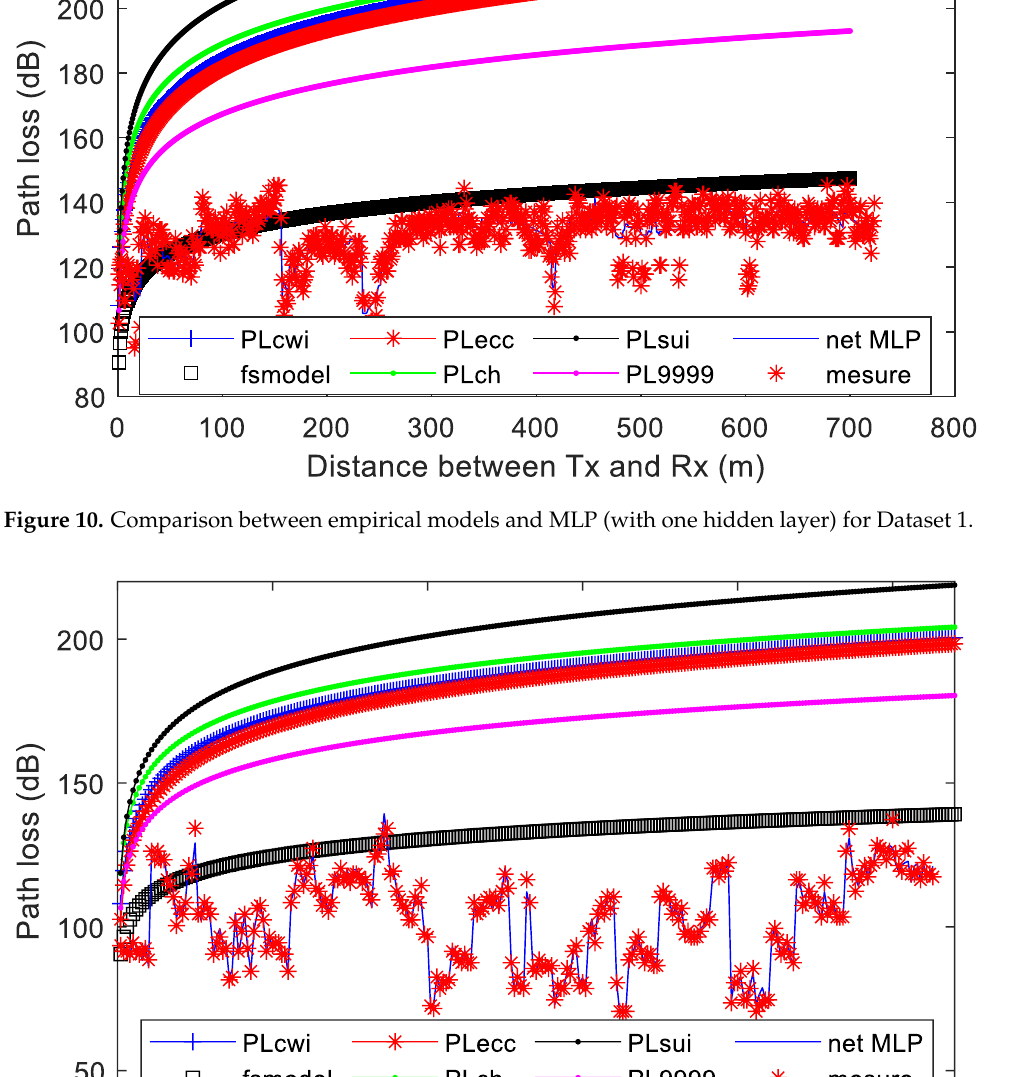
Figure 12. Comparison between empirical models and MLP (with one hidden layer) for Dataset 6.